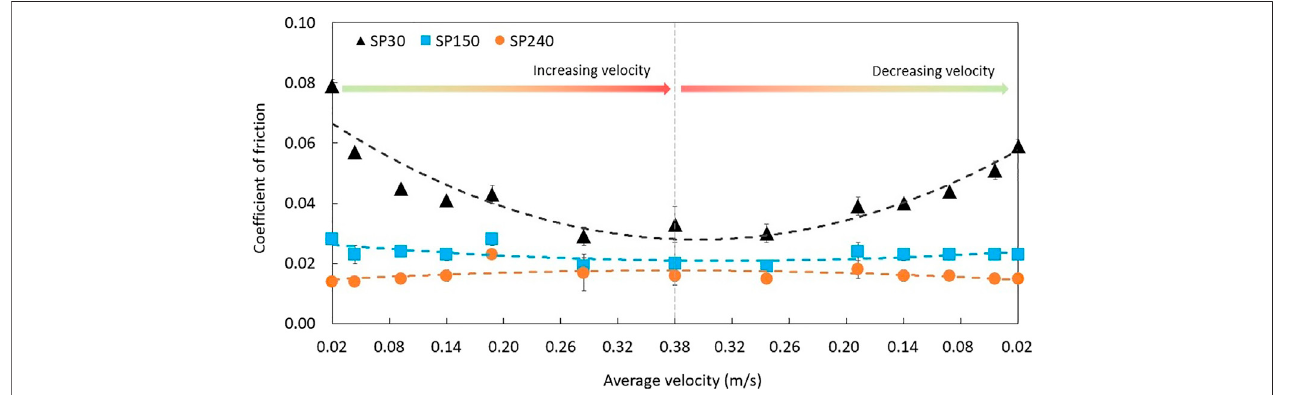
FIGURE 11 | Coef fi cients of friction measured on the oscillating tribometer. The obtained friction curves show that samples with higher contact area (smoother ones)yieldlowercoef fi cientoffrictionvalues.Atthesametime,thein fl uenceofvelocityonthecoef fi cientoffrictionisnoticeablyhigherfortheroughestsampleSP30than for the smother samples SP150 and